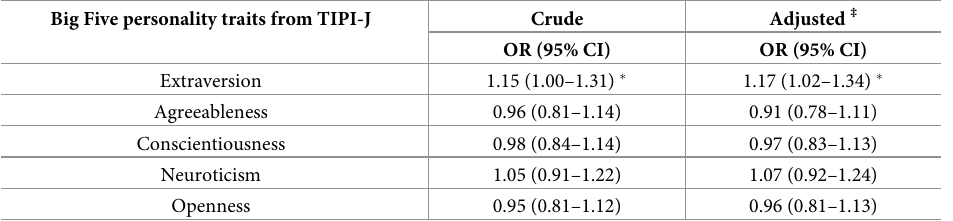
Table 5. Logistic regression results for association between Big Five personality traits and food stockpiling stage; “start stockpiling” vs “never stockpiled” (n = 721) † . Big Five personality traits from